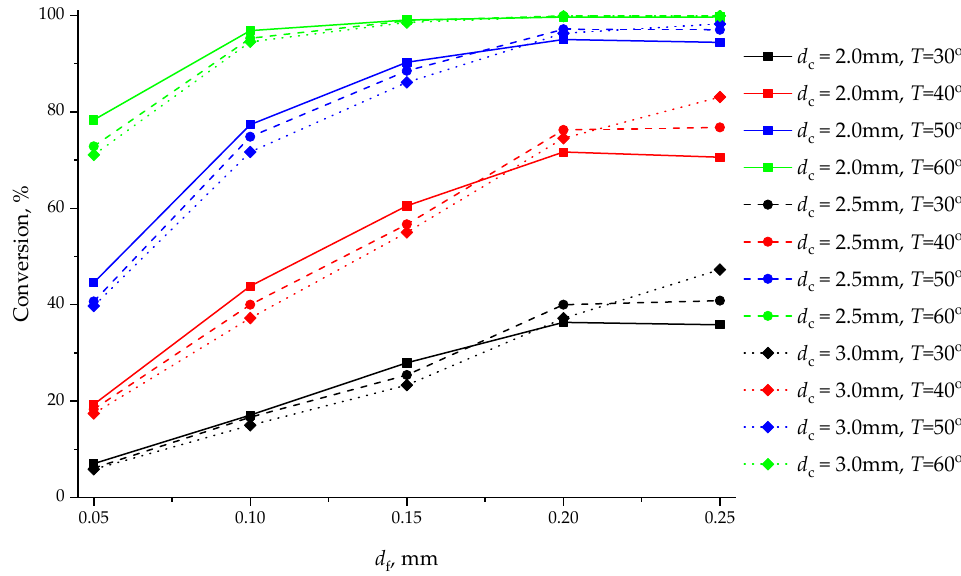
d . Figure 13. Conversion depending on the fiber diameter d f f